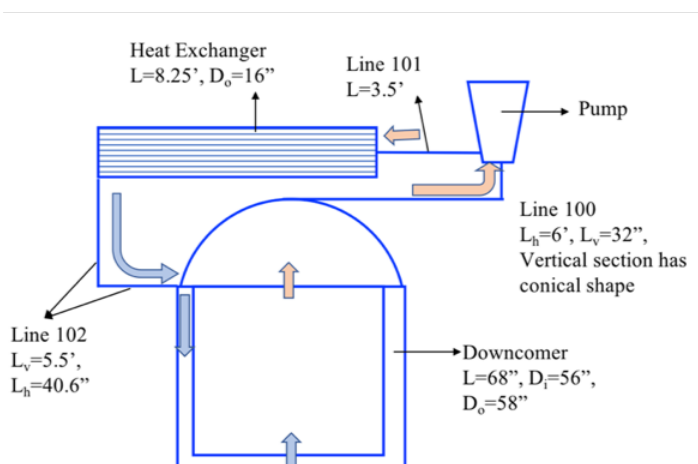
Figure 4. The schematics of the SAM model developed for the pump startup and coastdown tests.